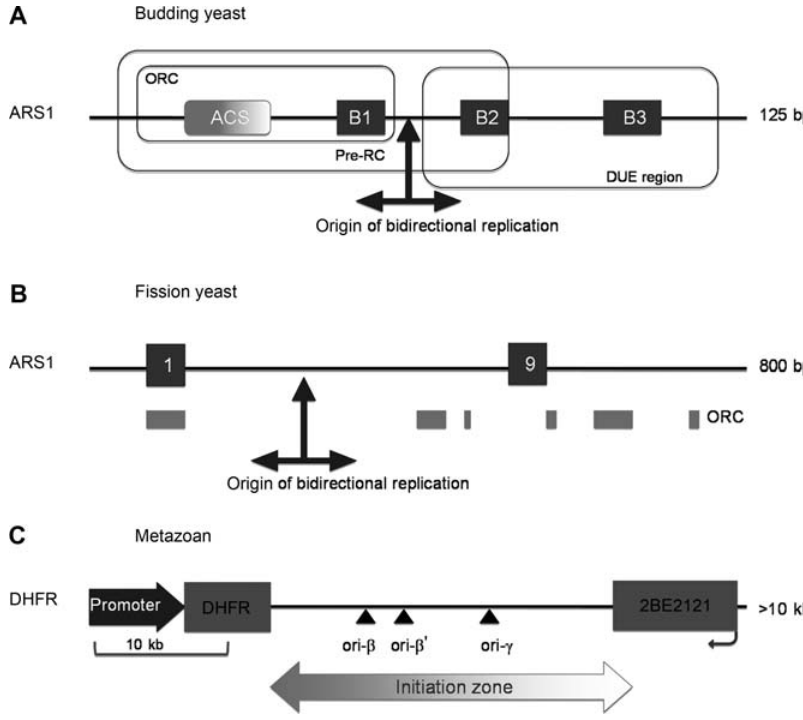
Figure 1 Origins of replication according to ‘‘DNA replication and human disease’’ (9). (A) Replicator of budding yeast showing the essential functional elements. ACS and B elements are marked as black boxes, DNA regions capable of binding purified ORC or protected by ORC and pre-RC are indicated by unfilled rectangles. DNA unwinding element is indicated by a similar rectangle. Arrows indicate the origins of the bidirectional replication. (B) Replicator of fission yeast showing the essential elements. Important regions are marked as numbered black boxes, whereas regions capable of binding purified ORC are indicated by smaller rectangles below the DNA strand. Arrows indicate the origins of bidirectional replication. (C) Replicator of metazoans. The light, gray, two- sided arrow indicates the initiation zone containing multiple origins of replication shown by the black triangles. The unfilled rectangle depicts the DHFR coding region. The promoter is marked as a dark arrow pointing in the direction of